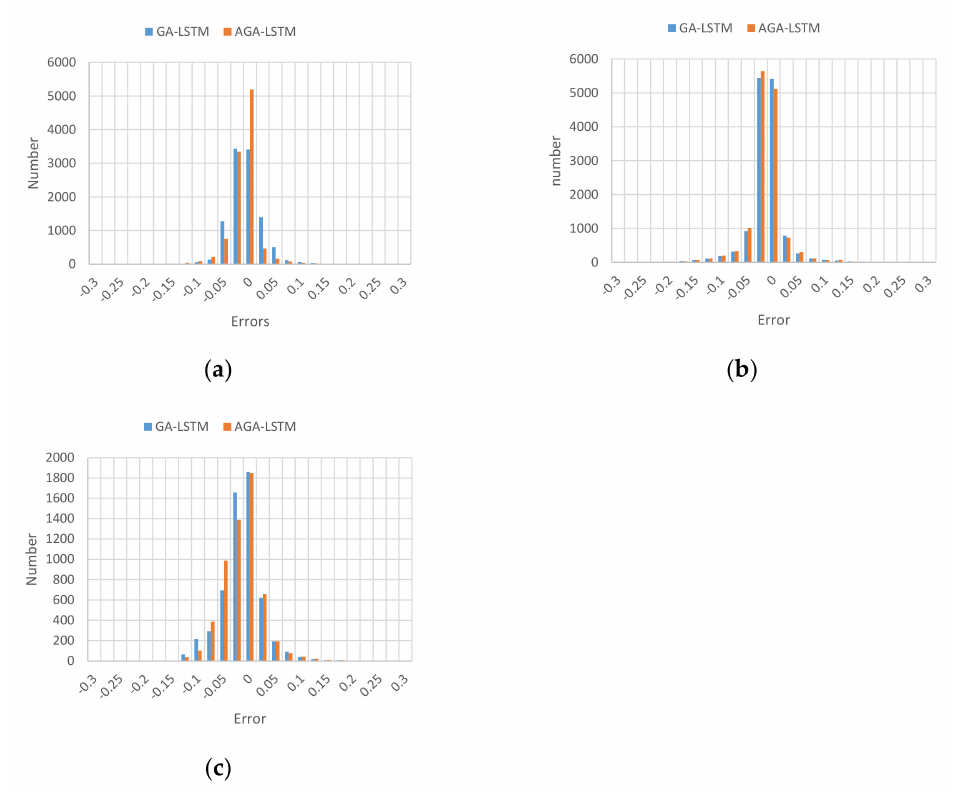
Figure 4. The relative error distributions of GHI by GA-LSTM and AGA-LSTM; ( a ) error distribution of 5 min prediction model; ( b ) error distribution of 10 min prediction model; ( c ) error distribution of 15 min prediction model.